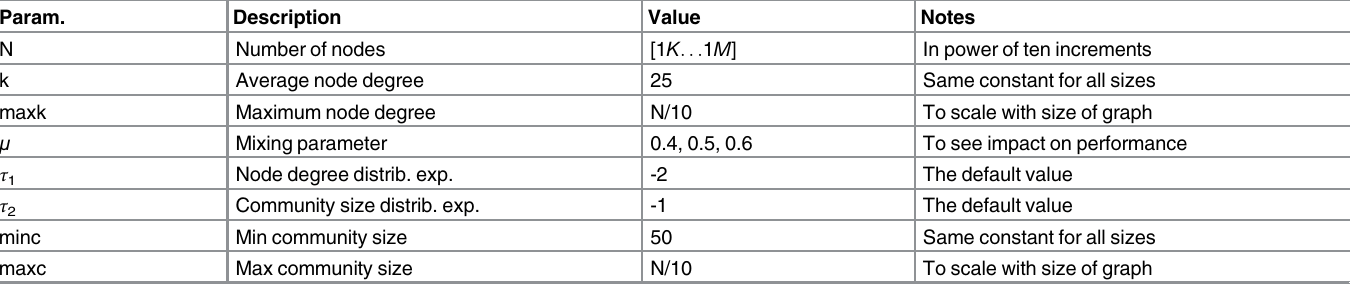
Table 1. LFR benchmark graph parameters.